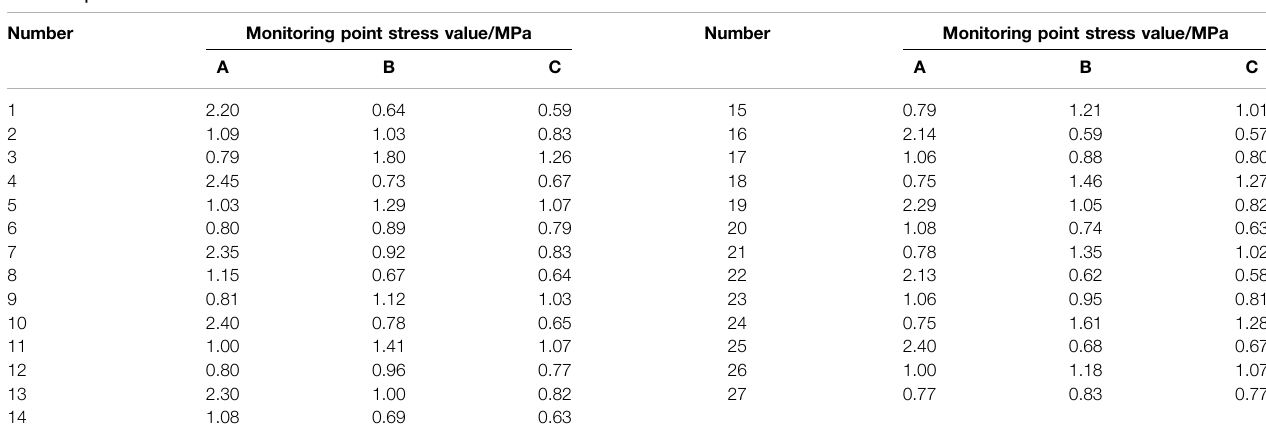
TABLE 6 | Rock stress